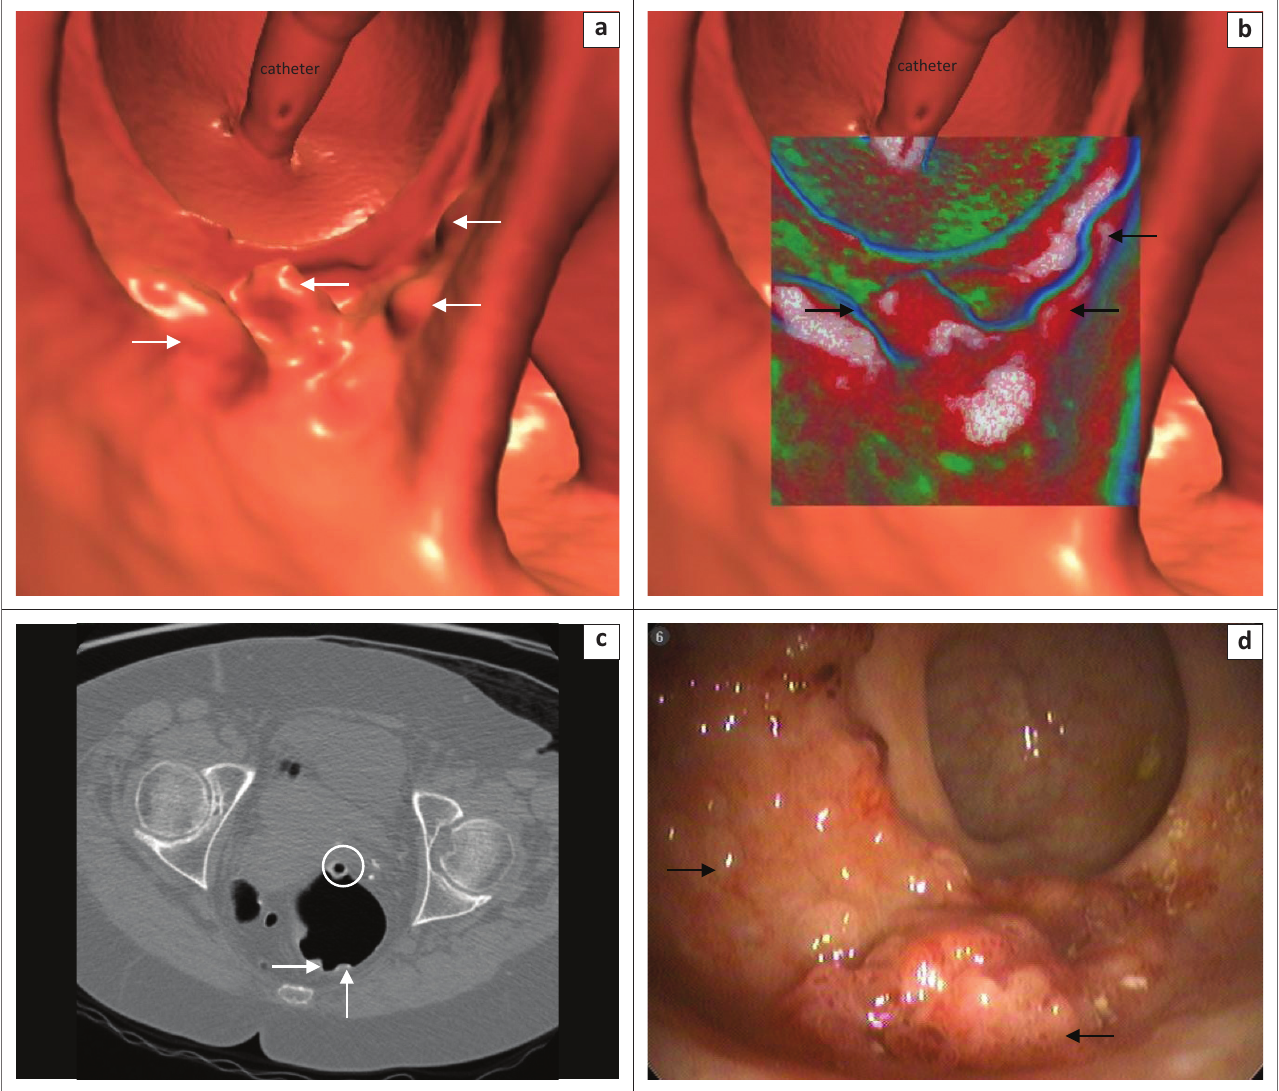
FIGURE 16: (a) 3D endoluminal view of rectum showing rectal catheter and carpet lesion extending for 40 mm (white arrows). Histology confirmed tubulovillous adenoma; (b) TD view showing rectal catheter and lobulated high intensity regions (black arrows) covered with a thin layer of barium (white); (c) 2D axial view of rectum with rectal catheter (white circle). Polyp view showing flat soft tissue lesion (white arrows). Note the etching of positive contrast material on the surface of the lesion; (d) Optical colonoscopy view confirms CTC finding of a minimally raised somewhat lobulated carpet lesion in the rectum (black arrows).